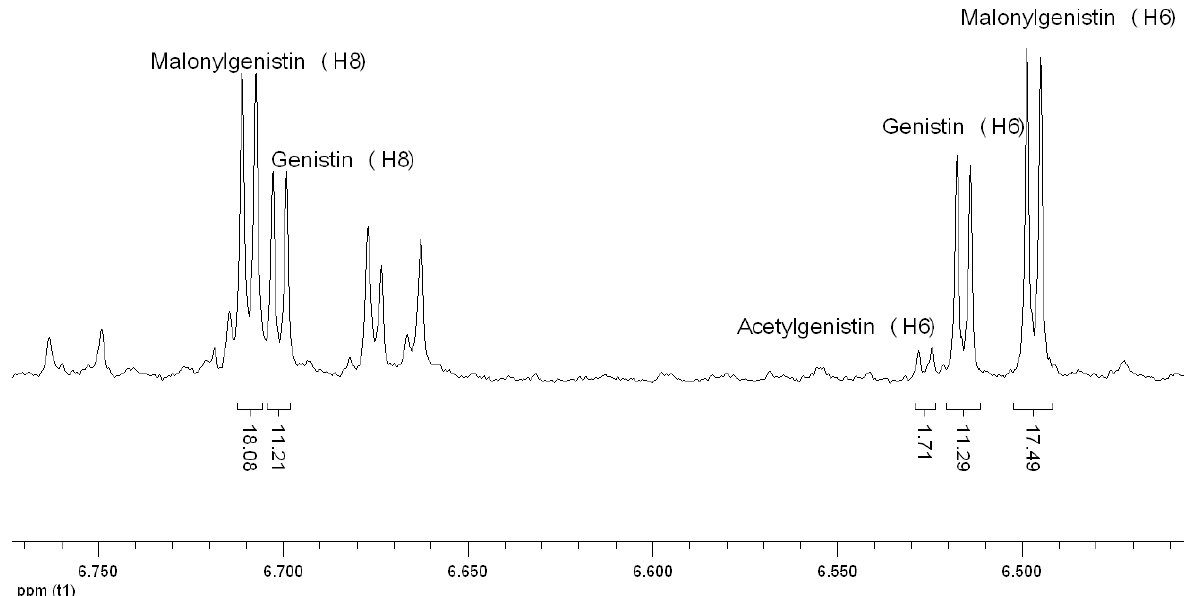
Figure 4. 1H NMR signals of hydrogen atoms linked to C6 and C8 of genistin and its conjugated